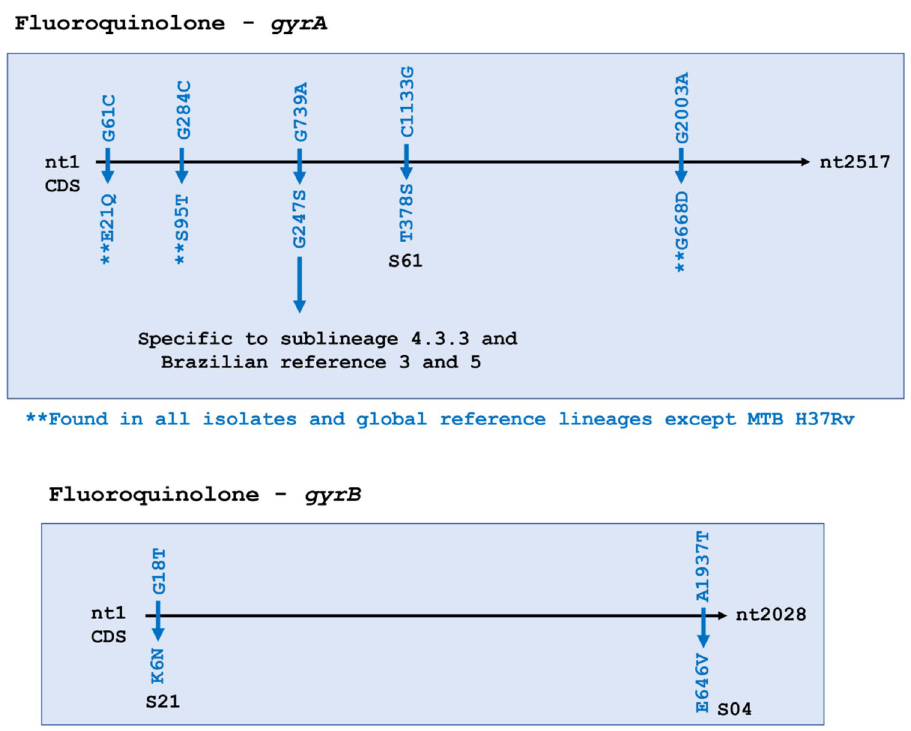
Figure 5. Fluoroquinolone resistance-associated genes gyrA and gyrB , had a few yet significant single nucleotide polymorphisms (SNPs). All SNPs were missense (blue). Three SNPs (**) in gyrA were fixed in the entire data set and all references except H37Rv, whereas one SNP in gyrA was found in 54/66 isolates. The former are not considered particularly informative, while the latter does appear to be. Two SNPs were observed in gyr